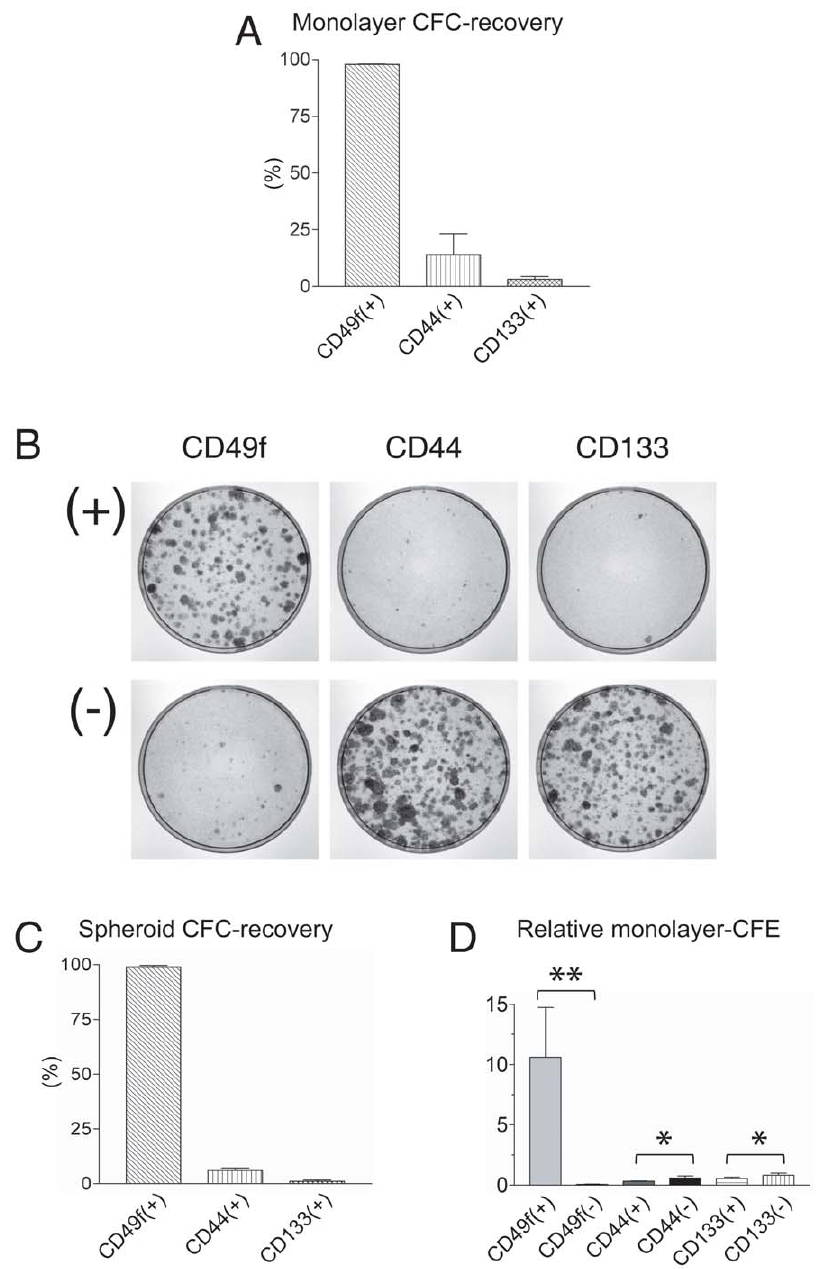
Figure 3. Comparison of markers for selection of monolayer- and spheroid-CFCs. [ A ] Following MACS, total monolayer-colonies arising from each ( + )ve and ( 2 )ve fraction were counted to determine the monolayer CFC-recovery, i.e. proportion of input CFCs which are fractionated to the ( + )ve fraction (n=3). The CD49f + fraction contained 97.9 6 0.3% of monolayer-CFCs, in contrast to CD44 + and CD133 + cell fractions which contained 13.9 6 17.9% and 3.1 6 1.9%, respectively. [ B ] A typical monolayer CFC-assay is shown. ( + )ve and ( 2 )ve fractions were derived from immunomagnetic sorting of 50,000 cells, each plated onto 10 cm culture dishes. [ C ] Following MACS, total spheroid-colonies arising from each ( + )ve and ( 2 )ve cell fractions were counted to determine the spheroid CFC-recovery (n=3). The CD49f + fraction contained 98.9 6 1.1% of spheroid CFCs, in contrast to CD44 + and CD133 + cell fractions which contained 5.7 6 2.1% and 0.7 6 0.6%, respectively (p , 0.001). [ D ] CD49f + were 10.6 fold more enriched in CFCs compared to unsorted cells, and significantly more enriched in CFCs compared to CD49f 2 cells (p , 0.05) (n=6). No significant CFC enrichment was detected upon comparison of CD44 + and CD44 2 cells ( n =5), or between CD133 + and CD133 2 cells (n=3), respectively. ** p , 0.05, * p . 0.05. doi:10.1371/journal.pone.0046979.g003 CD31 + endothelial cells (Figures 5C,D). The fact endothelial cells eliminate clonogenic cells and abnormal endothelial cells associ- expressed CD49f is pertinent in the context of cancer treatment, as ated with neovascularisation. neovascularization is a critical hallmark of cancer [34]. Targeting We found a lack of AR expression in a subpopulation of CD49f + cells in prostate cancer could therefore simultaneously CD49f + cells (Figure 5F), consistent with a study that showed AR